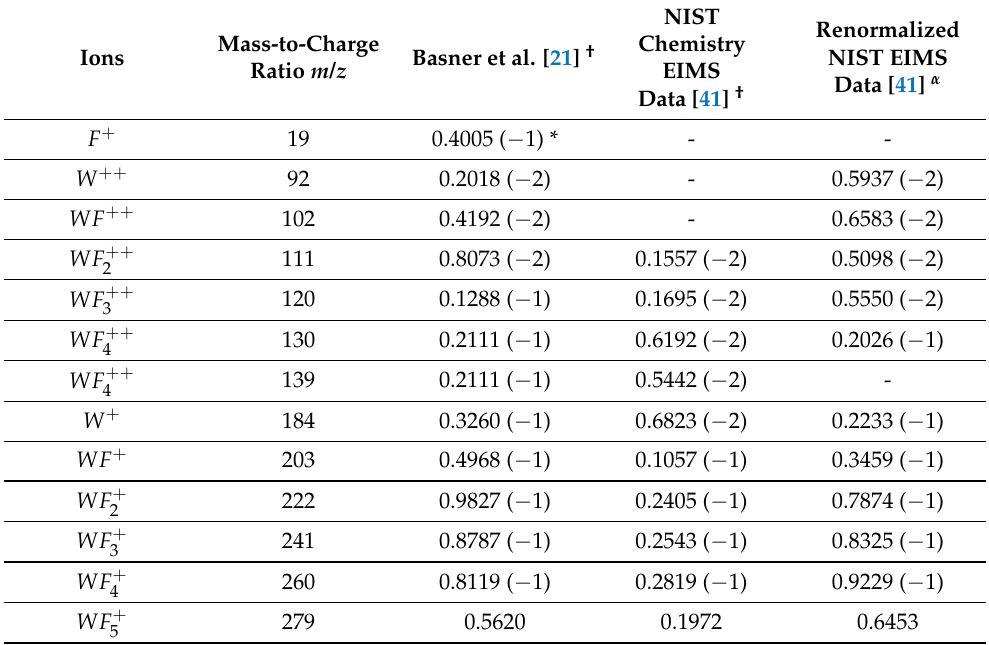
Table 1. Branching ratios (BR) of various cations of WF 6 produced by electron impact dissociation at 70